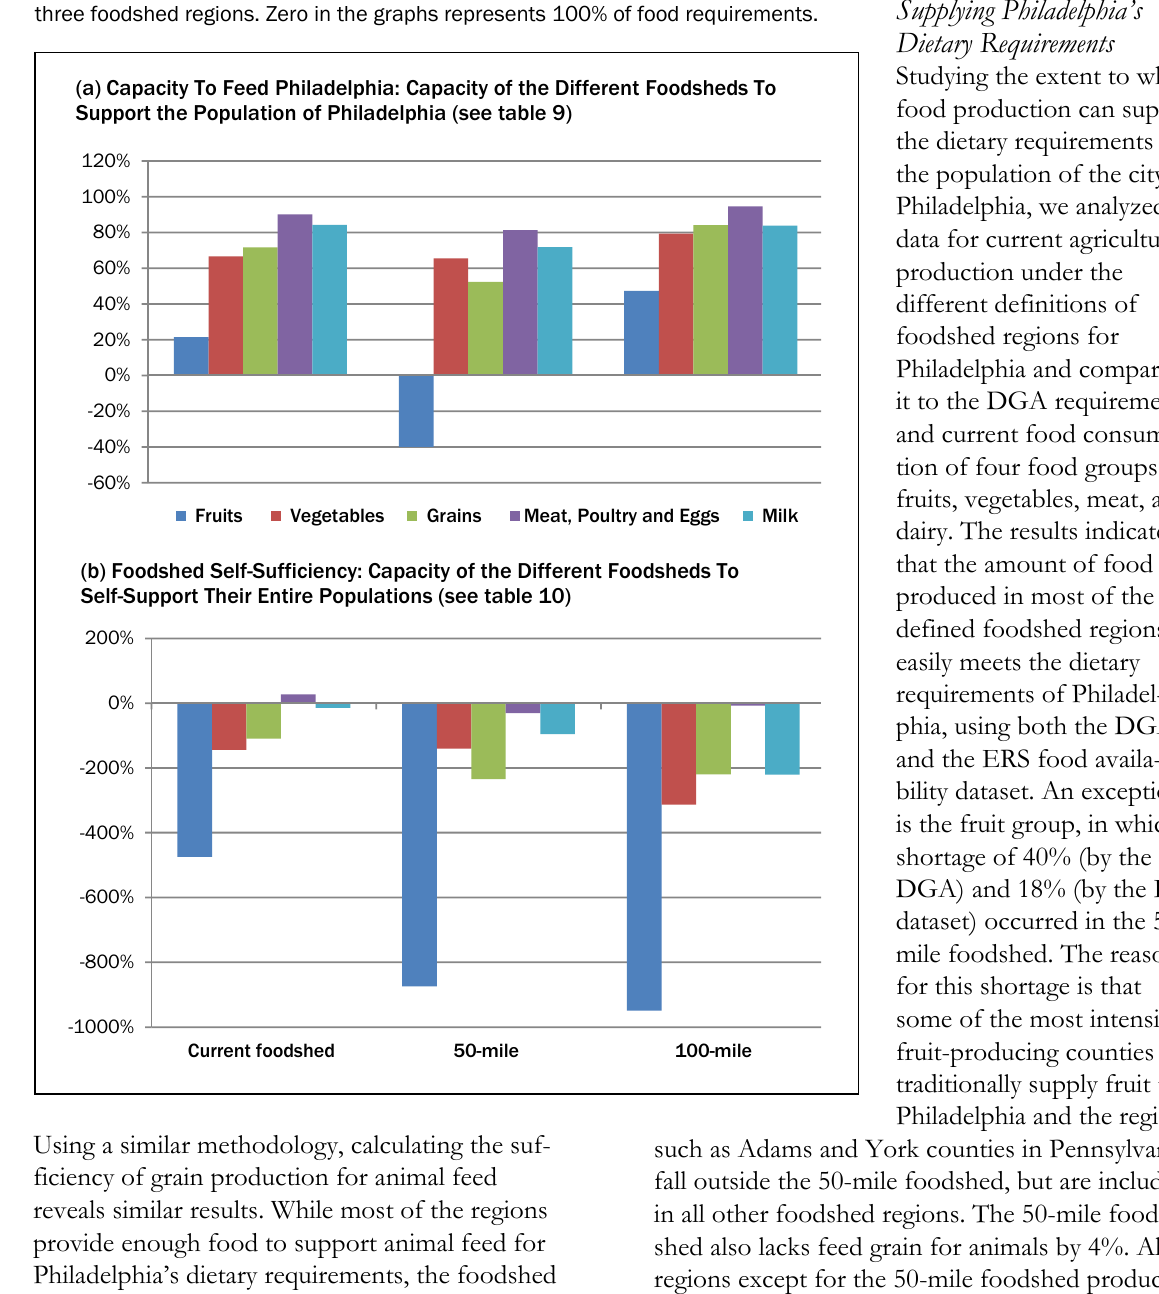
Figure 6. The Capacity To Support Food Requirements Based on the DGA The regional capacity to support food requirements under federal food guidelines in three foodshed regions. Zero in the graphs represents 100% of food